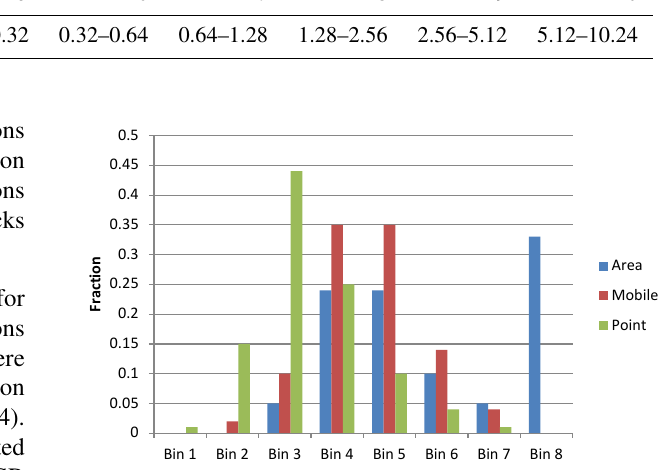
Figure 4. Fractional distribution of the eight PM 2 . 5 size bins for the 12-bin version of GEM-MACH modeling for three broad types of emissions